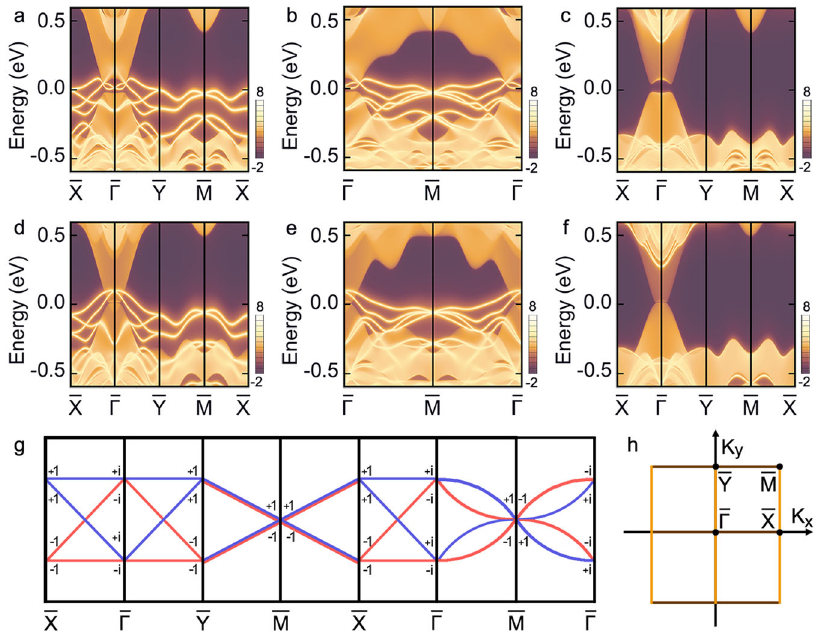
Fig. 3 Surface spectrum for wallpaper fermion. Band structures for (001) surface of a – c Tl 4 PbTe 3 and d – f Tl 4 SnTe 3 calculated using surface Green ’ s functions. The Fermi level is set to zero. a , b , d , e The top surface displays hourglass fermions along the glide-symmetric lines Γ X = Γ Y and the fourfold Dirac fermion at the M point, while c , f there is no surface bands on the bottom surface. g Schematic of wallpaper fermions along the glide-invariant lines G x = y . The labels indicate the corresponding eigenvalues ± ie (cid:2) ik x = y = 2 . h Brillouin zone of the (001)-surface with G G x / y invariant lines are indicated by yellow/brown